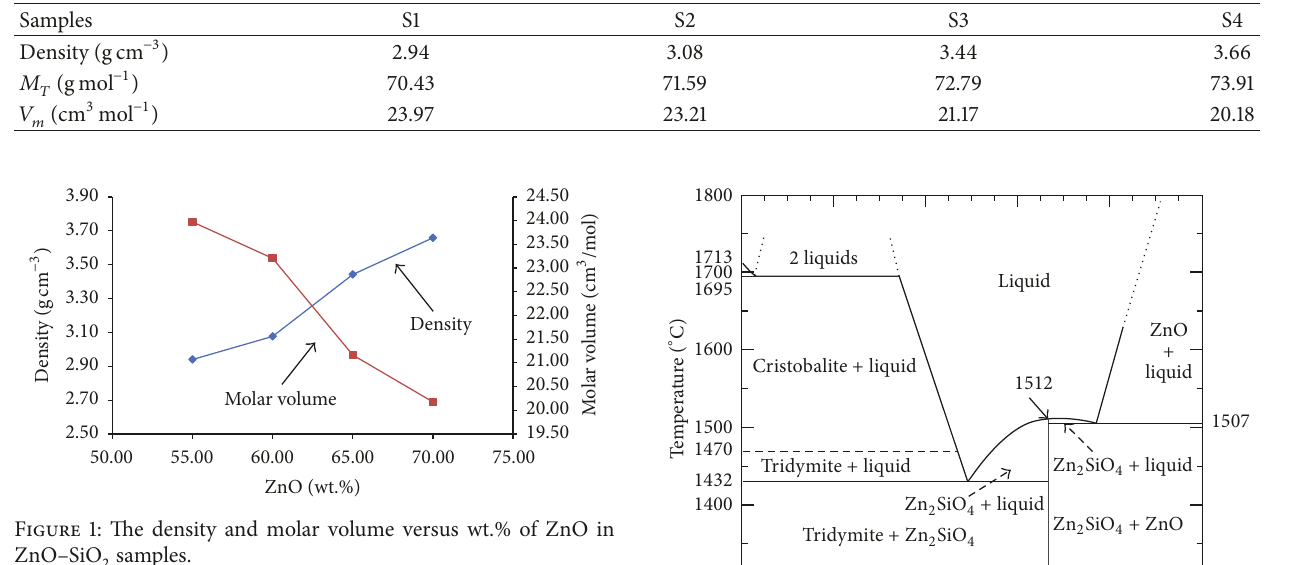
Table 2: Density, molecular weight, and molar volumeof ZnO–SiO 2 samples.